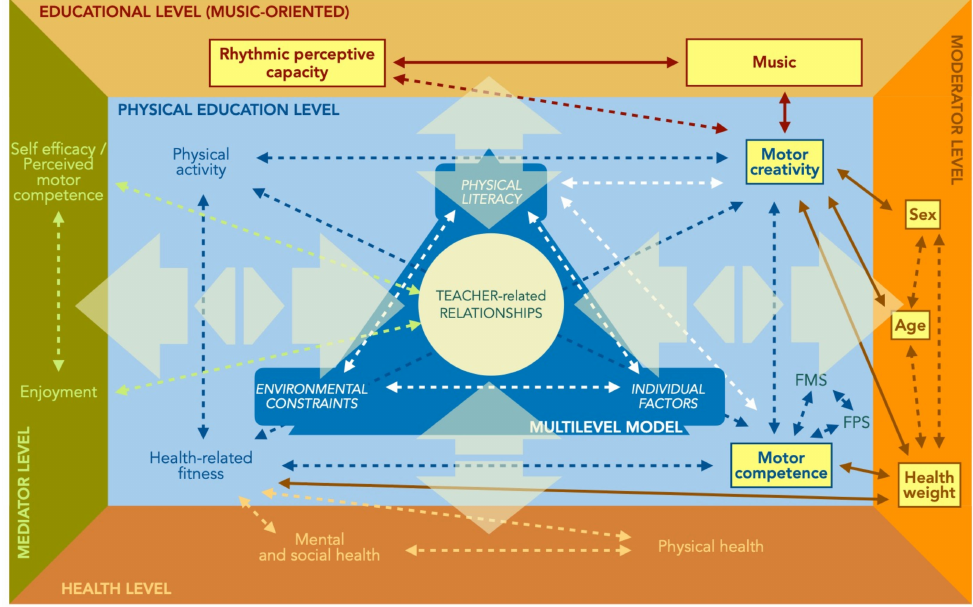
Figure 5. The framework of the ecological model in physical education. Yellow labels: core categories in the present study. Continuous lines: main detected effects. FMS = fundamental motor skills; FPS = fundamental play